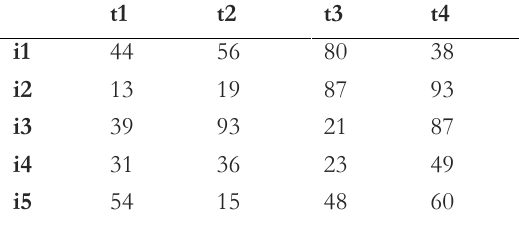
Table 9. The exact location of demand.